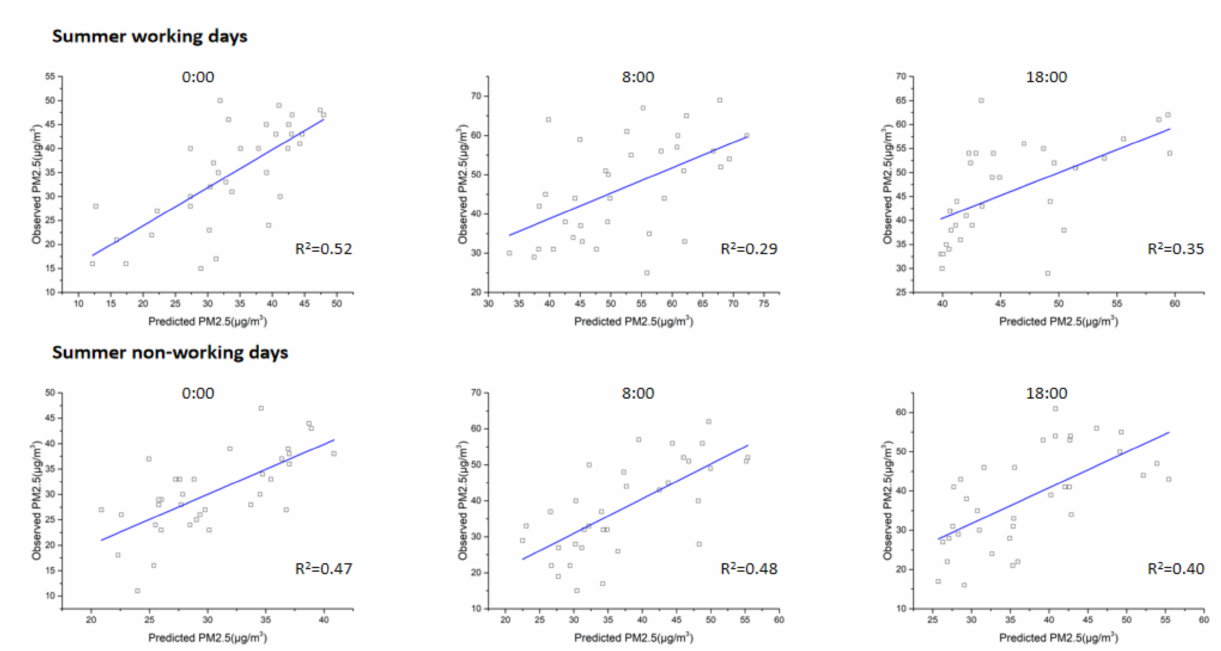
Figure 3. Scatter plots of the PM 2.5 predictions from the Kriging method and the monitoring